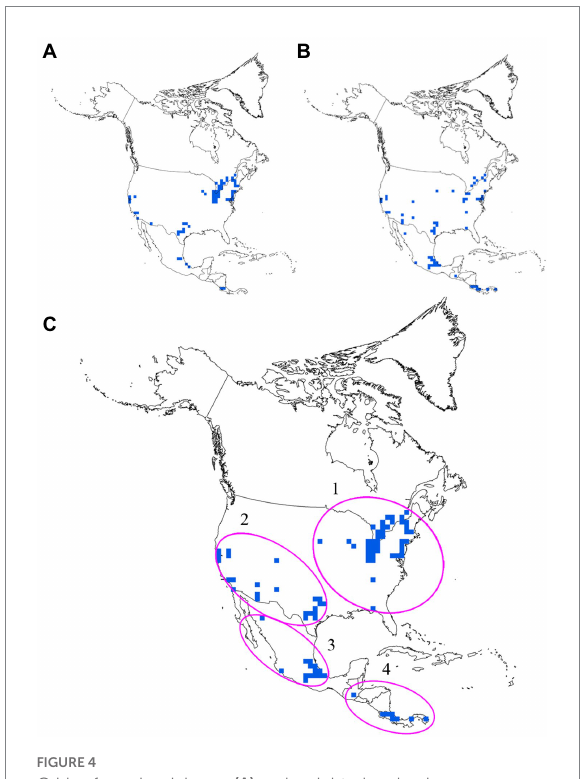
FIGURE 4 Grids of species richness (A) and weighted endemism (B) hotspots and conservation priority areas (C) .